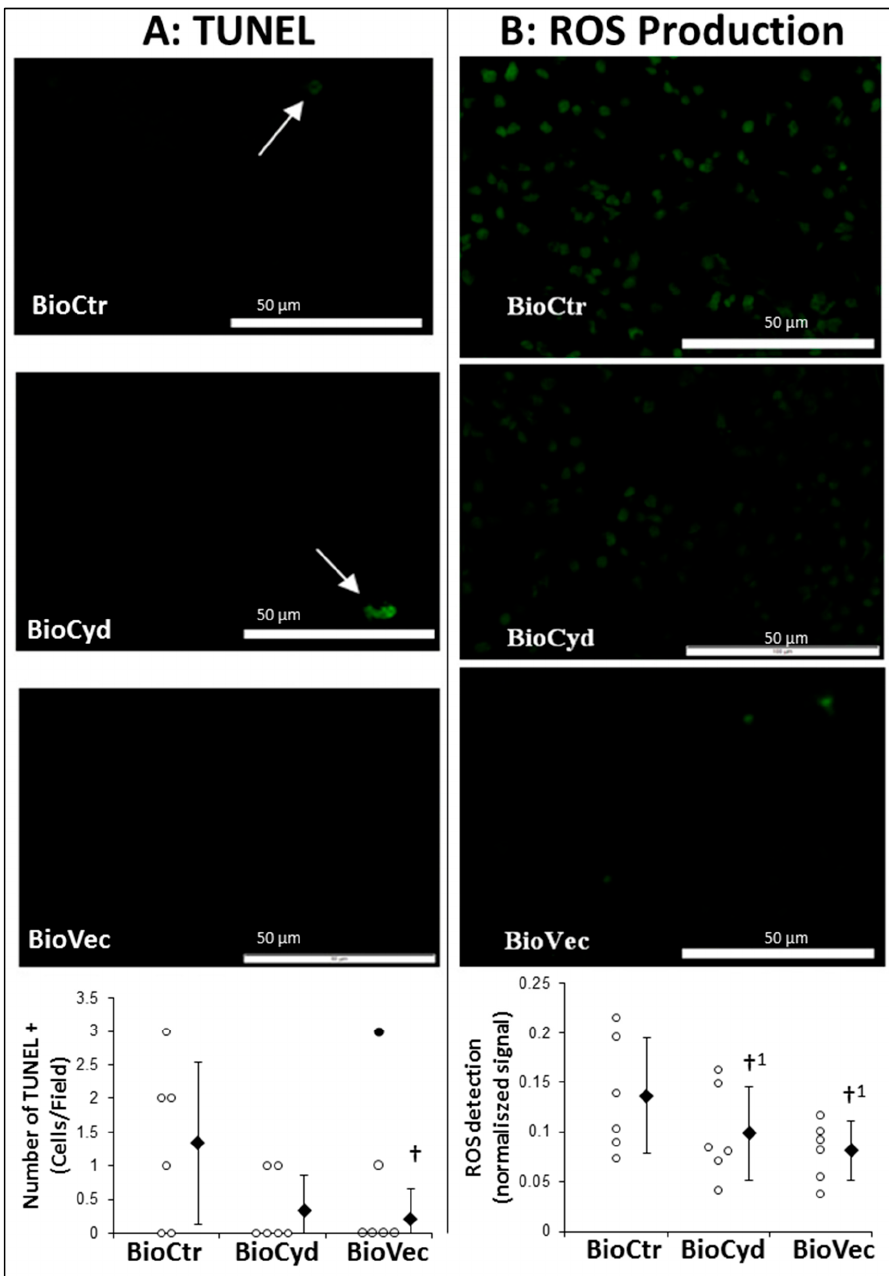
Figure 4. Evaluation of Vectisol ® benefits during machine preservation 30 min after reperfusion. Cortical biopsies were collected 30 min after reperfusion and snap-frozen in an OCT (Optimal Cutting Temperature) compound. Samples were processed for TUNEL ( A ) or CellRox ( B ) staining, and signals were quantified as exposed in the methods. Representative images for each group are shown, and quantification of signals for all animals is presented at the bottom. Shown are each data point (empty dots) as well as mean ± SD (filled diamonds), statistics (Dunn’s Test followed by Kruskal Wallis post-hoc): † : p < 0.05 to BioCtR, † 1 : p < 0.05 to BioCtr one-sided test; black dots are